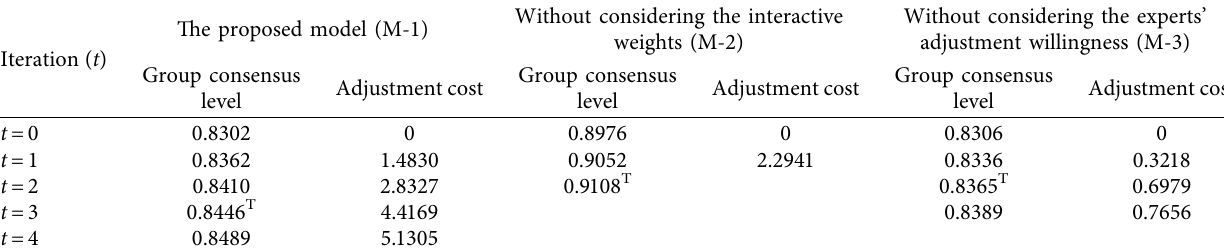
Table 20: .e change of GCL